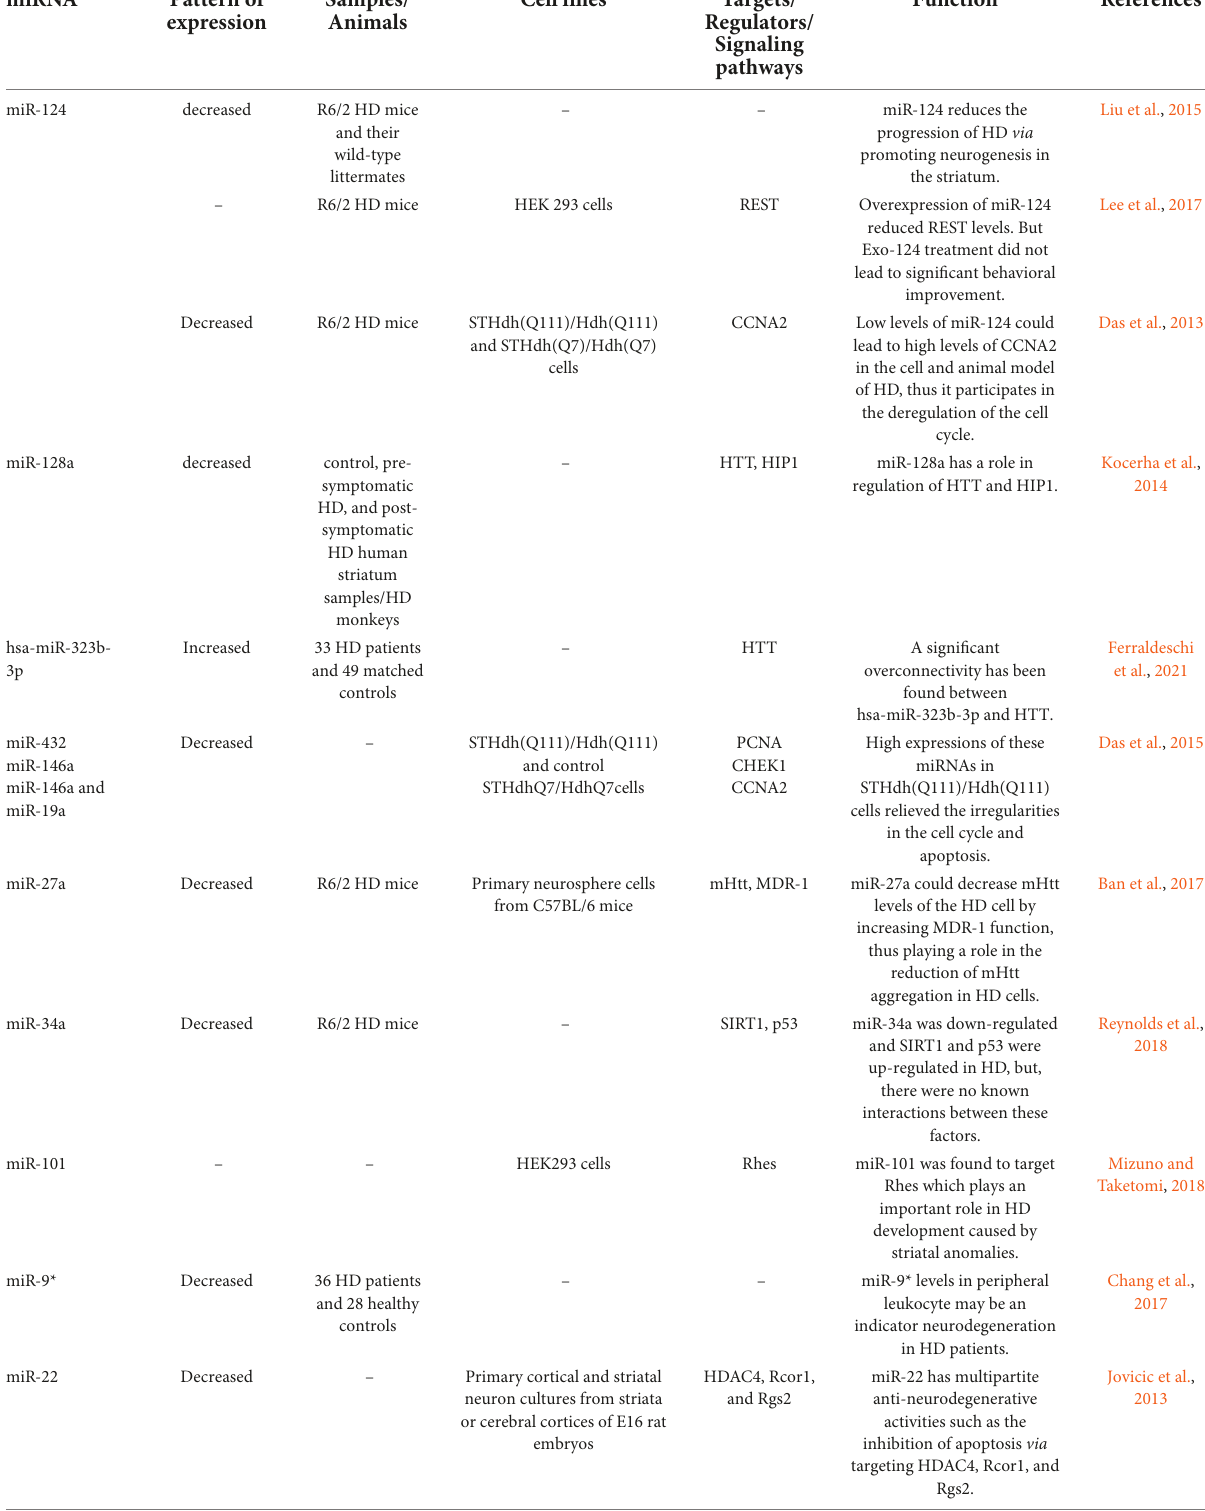
TABLE 1 MicroRNAs and Huntington’s disease (HD, Huntington’s disease; UHDRS, Unified Huntington’s Disease Rating Scales).